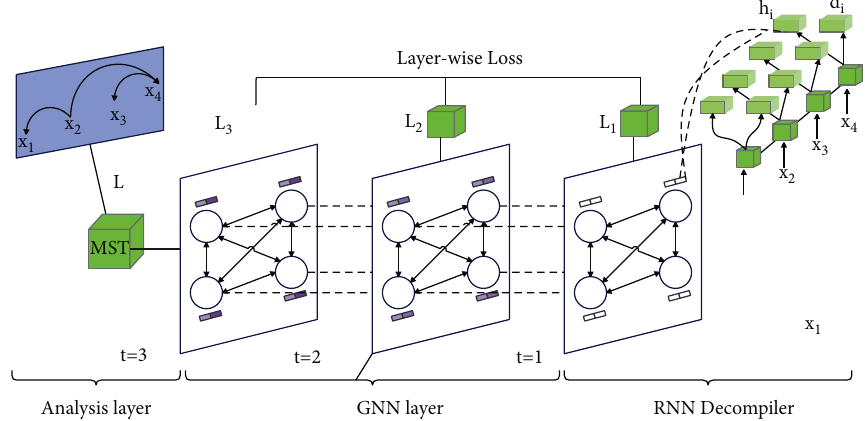
Figure 6: Dependency English syntax analyzer based on graph neural